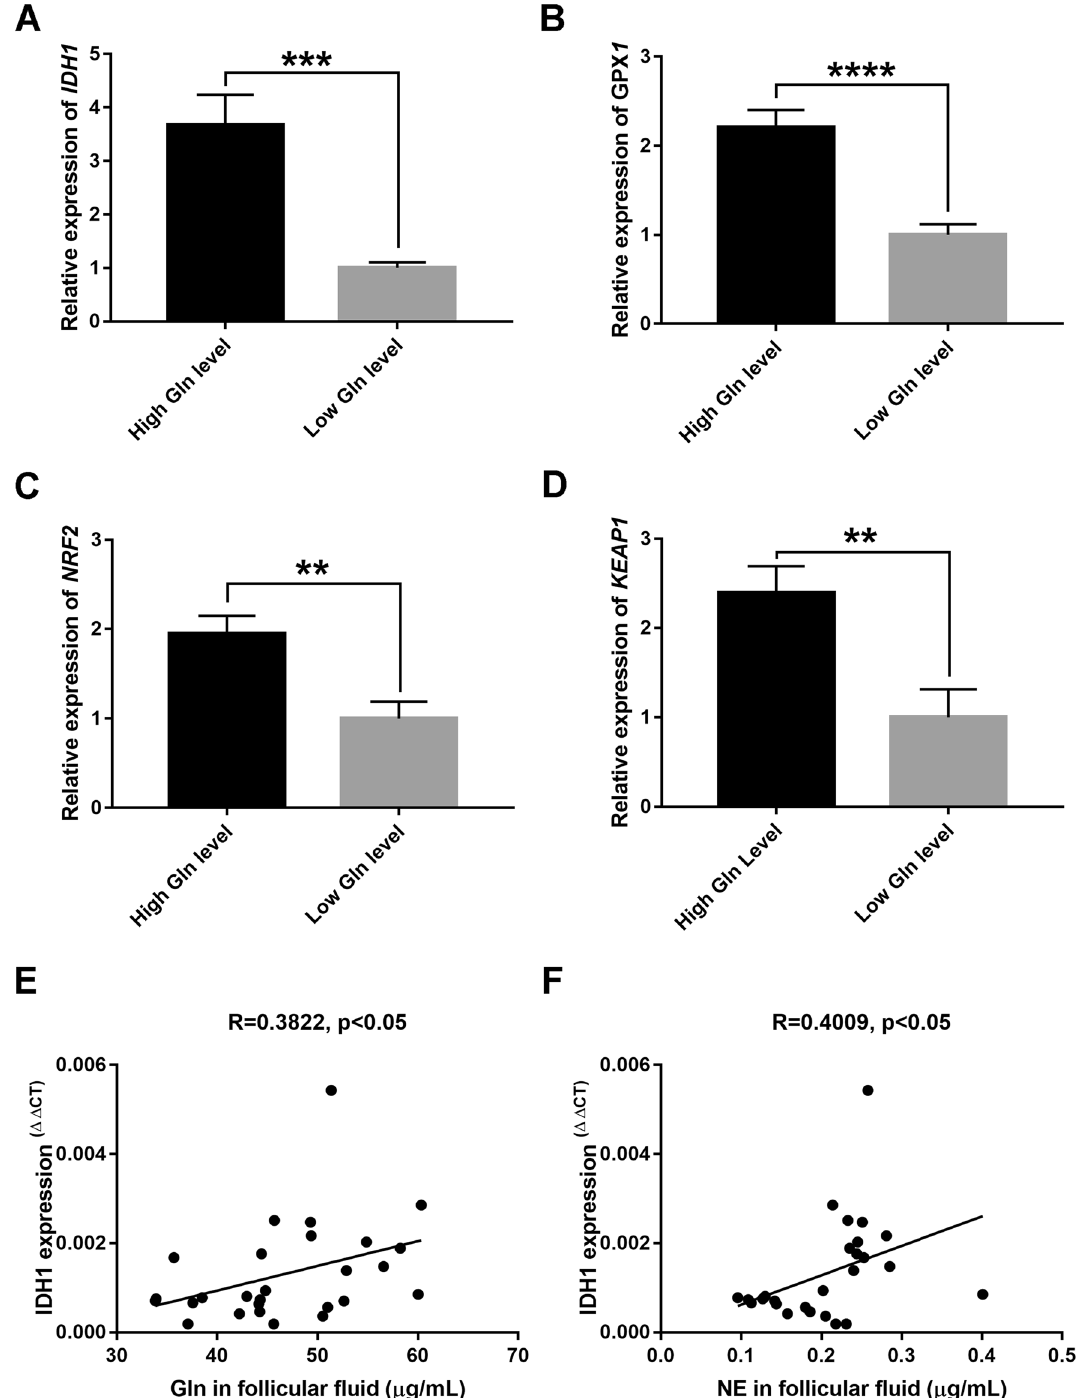
Figure 4. The expression levels of the antioxidative genes in the cumulus granulosa cells between high and low glutamine (Gln) level groups. ( A – D ) The column charts demonstrate the expression of antioxidant genes in the two groups, including IDH1, GPX1, NRF2, and KEAP1. ( E ) Correlation analysis of Gln concentration in follicular fluid and IDH1 mRNA expression in cumulus granulosa cells (GCs) (n = 27, R = 0.3822, P < 0.05). ( F ) Correlation analysis of norepinephrine (NE) concentration in follicular fluid and IDH1 mRNA expression in cumulus GCs (n = 27, R = 0.4009, P < 0.05). Data represent the mean values ± standard error of the mean (mean ± SEM). High Gln level, n = 14; Low Gln level, n = 13. All indicated P values were determined by Student’s t test. ** P value < 0.01; *** P value < 0.001; **** P value <